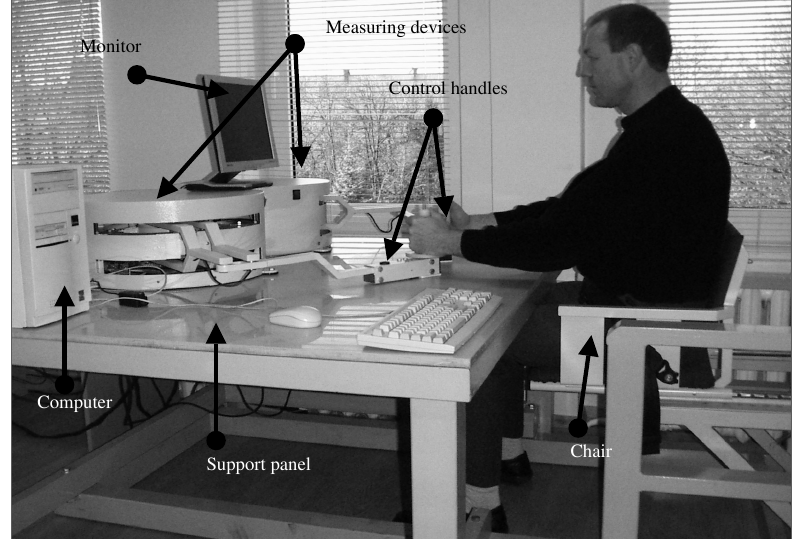
Figure 1. The analyzer of dynamic parameters of human leg and arm